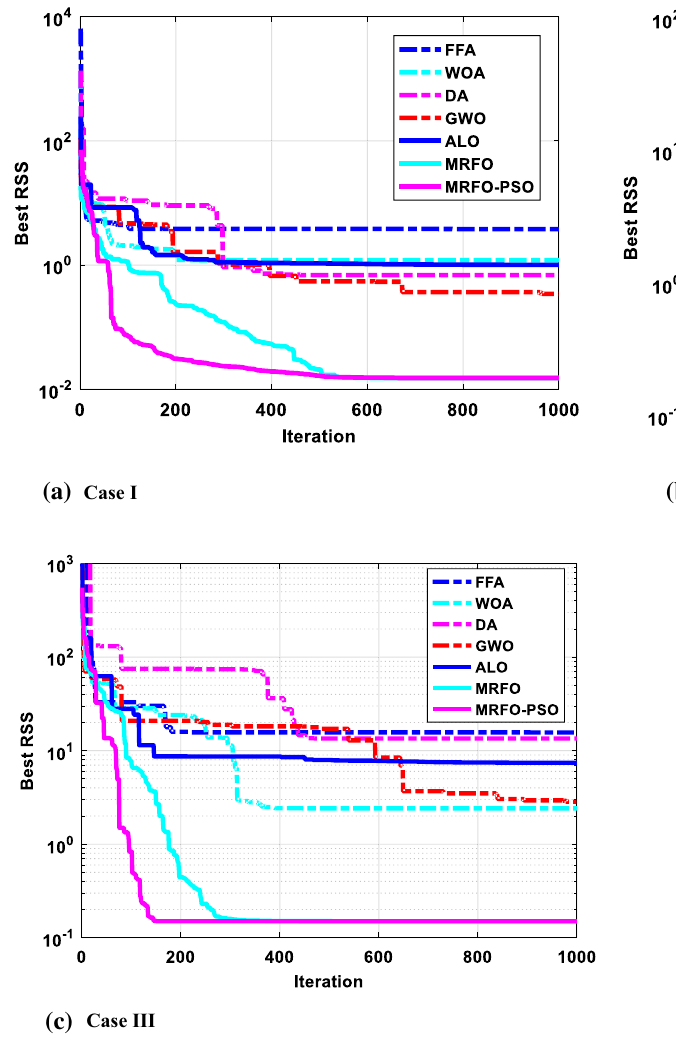
Fig. 6 Convergence curve of RSS for the studied